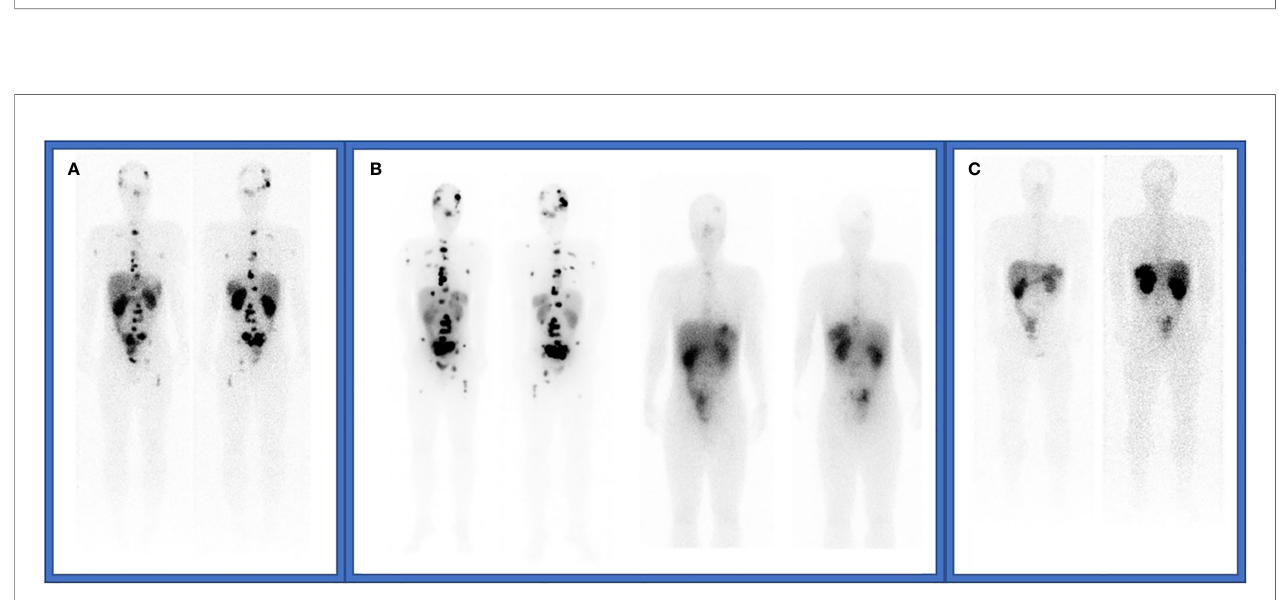
FIGURE 1 | (A) Octreoscan imaging in December 2015, before de fi rst treatment with 177Lu-DOTATATE. (B) SPECT-CT studies after fi rst and fourth 177Lu- DOTATATE doses. (C) Octreoscan imaging in November 2016, after fi nishing fi rst treatment with 177Lu-DOTATATE. (D) SPECT-CT studies in December 2015 and November 2016.